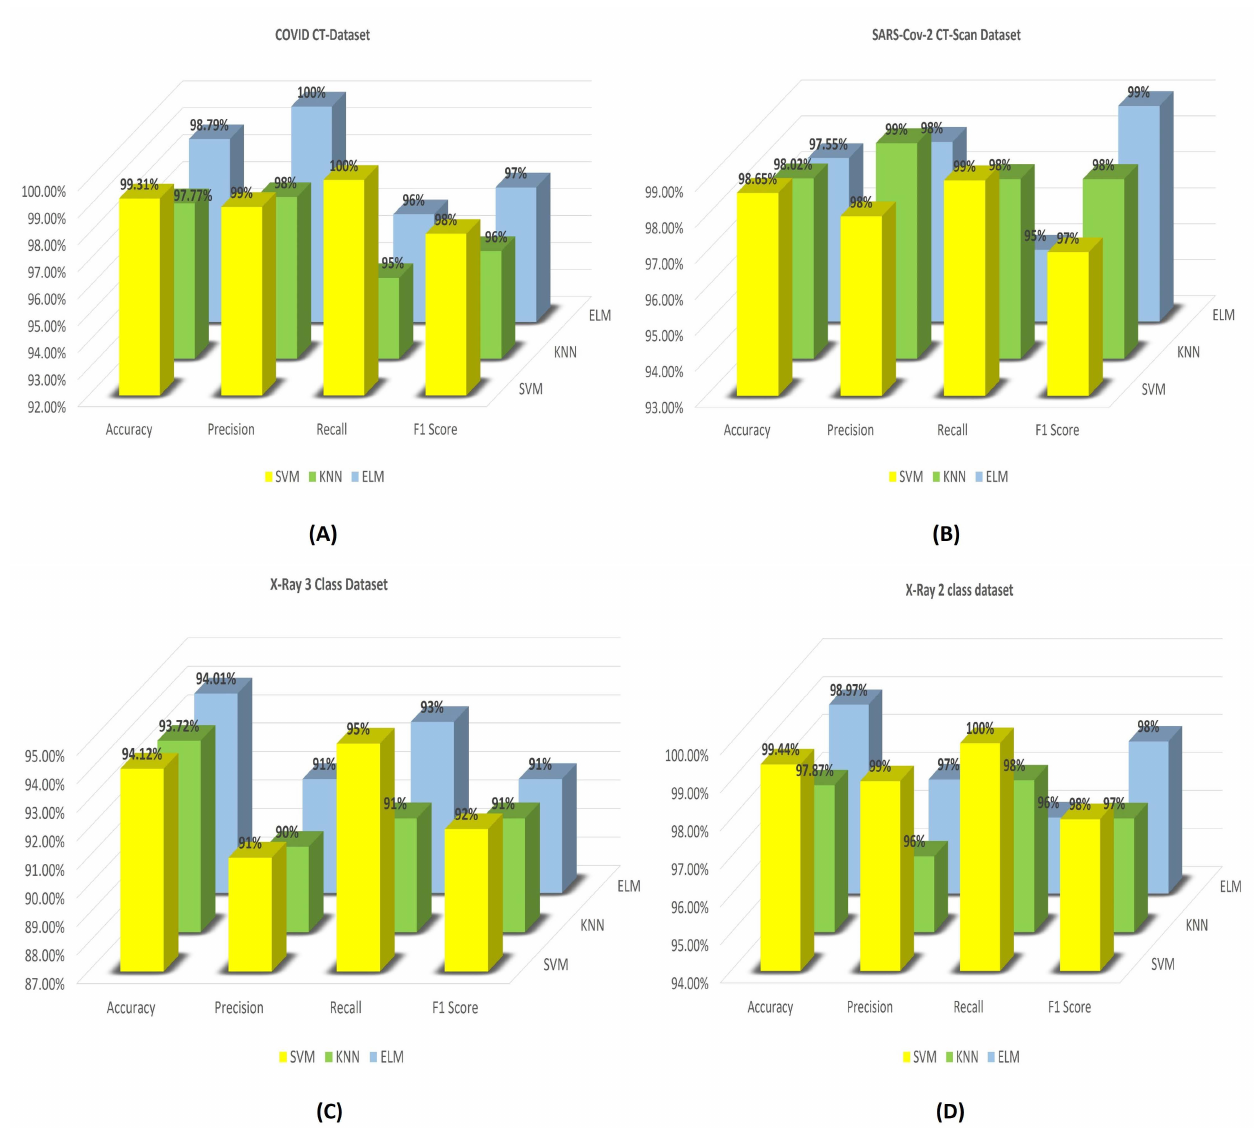
Figure 9. Results obtain by our proposed CGRO based FS algorithm using three different classifiers on: ( A ) COVID CT-Dataset, ( B ) SARS-Cov-2 CT-Scan dataset, ( C ) Chest X-ray 3-class of Muhammed Talo, and ( D ) Chest X-ray 2-class dataset of Muhammed